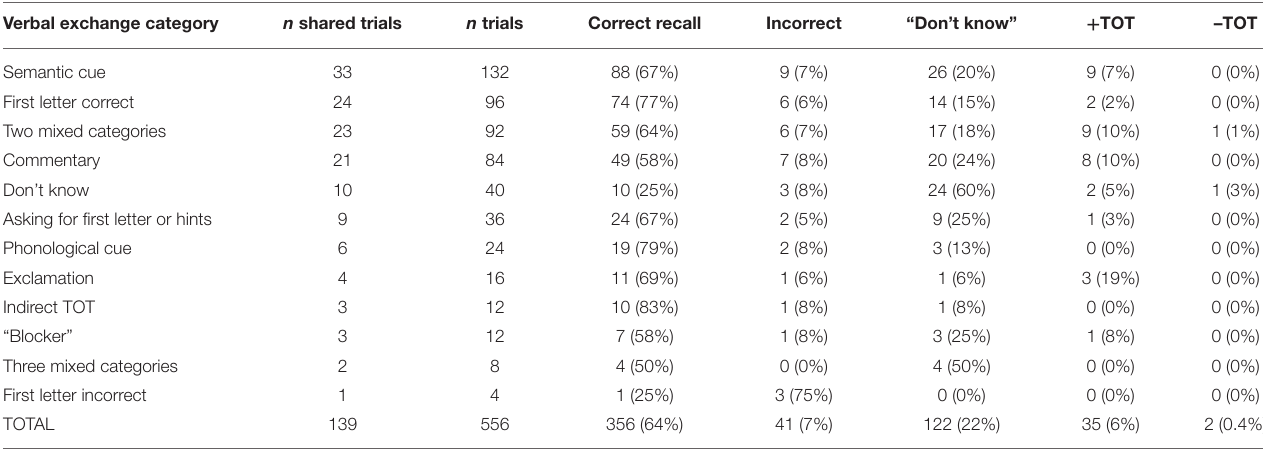
TABLE 3 | Correctly recalled items, incorrect and “Don’t Know” responses, positive and negative TOTs, expressed as a frequency (percentage) of trials, by verbal exchange category. Verbal exchange